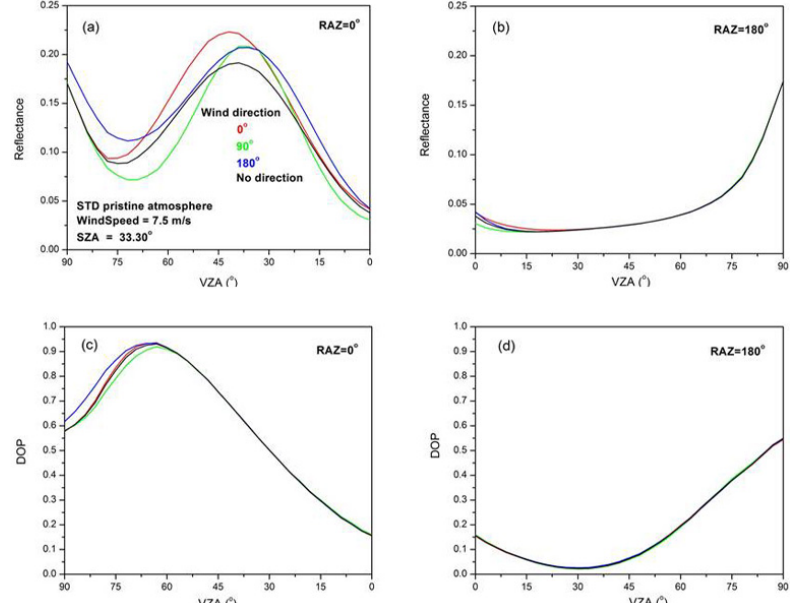
Fig. 10. The total reflectance and DOP of the ocean–atmosphere system on the principal plane, which is calculated with the ADRTM at a wavelength of 670nm. Pristine US standard (STD) atmosphere is used. The solar zenith angle is 33.30 ◦ . Wind speed is 7.5ms − 1 . Both the ocean wave slope probability distribution model with wind-direction dependence and the one without wind-direction dependence are used in the calculation. In the ocean wave slope probability distribution model with wind-direction dependence, wind direction is set at 0, 90, and 180 ◦ , respectively.